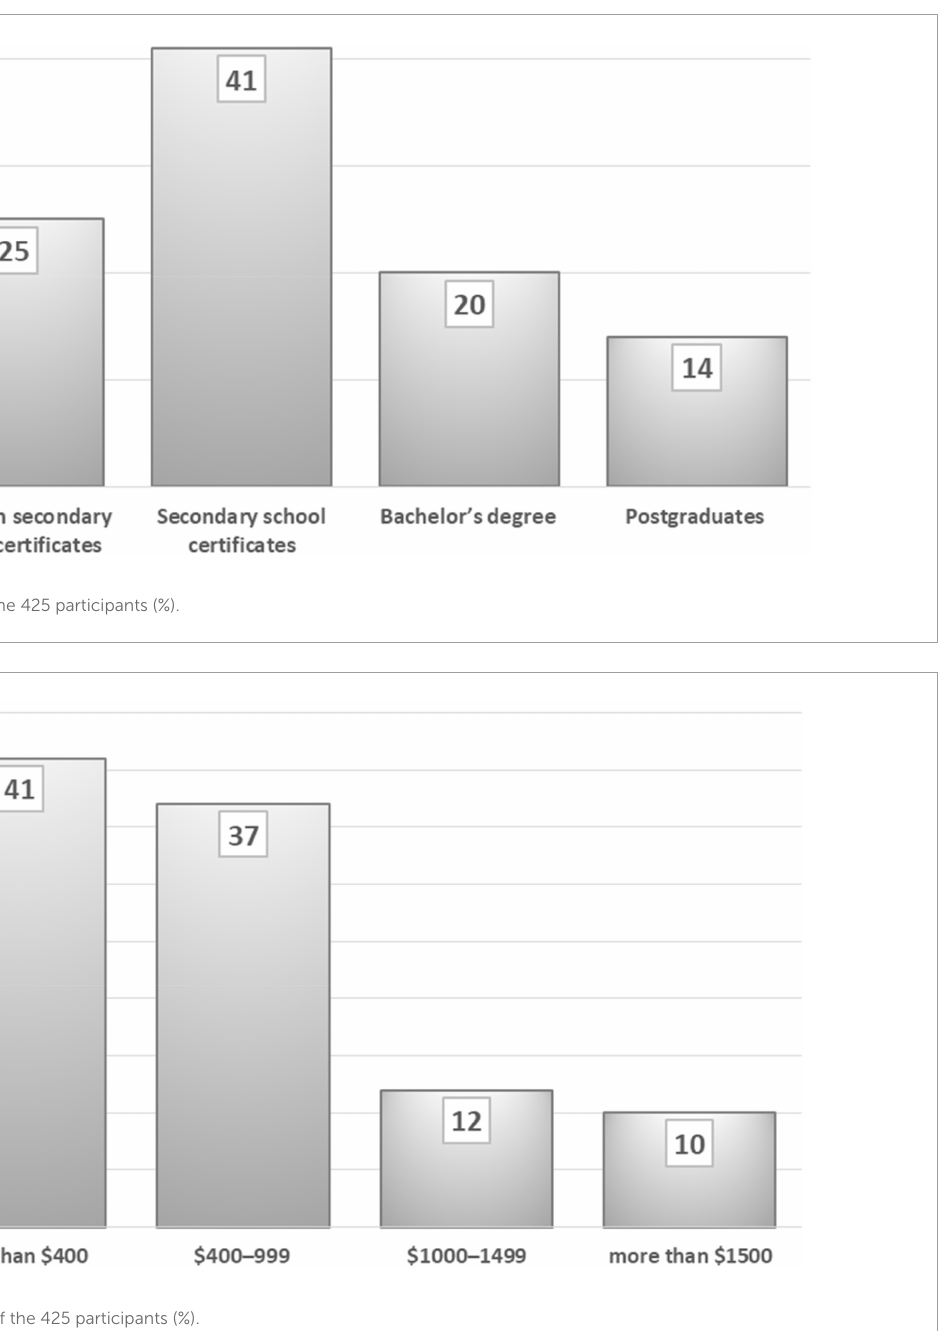
FIGURE4 Monthly household income of the 425 participants